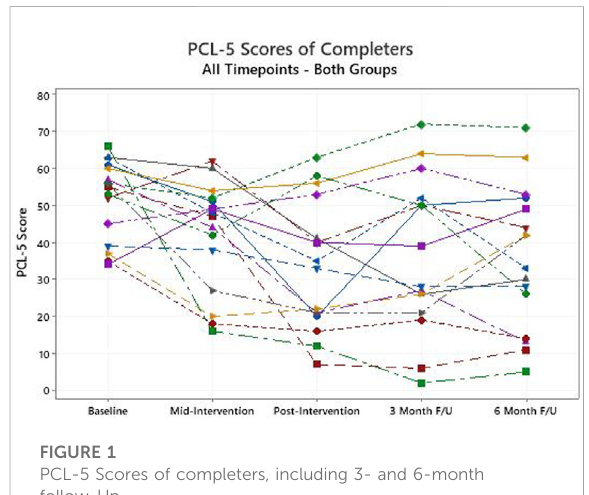
FIGURE 1 PCL-5 Scores of completers, including 3- and 6-month